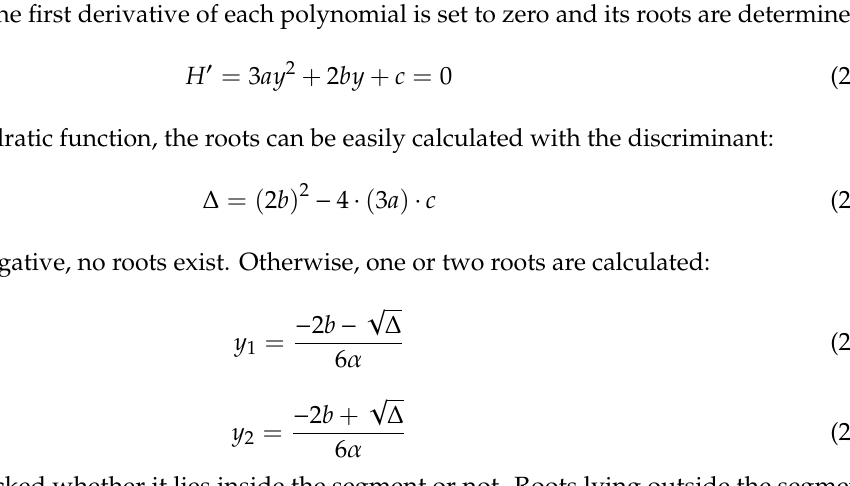
(28) Table 1 . Outline of Adaptive Cubic Polynomial Algorithm (ACPA) 1.